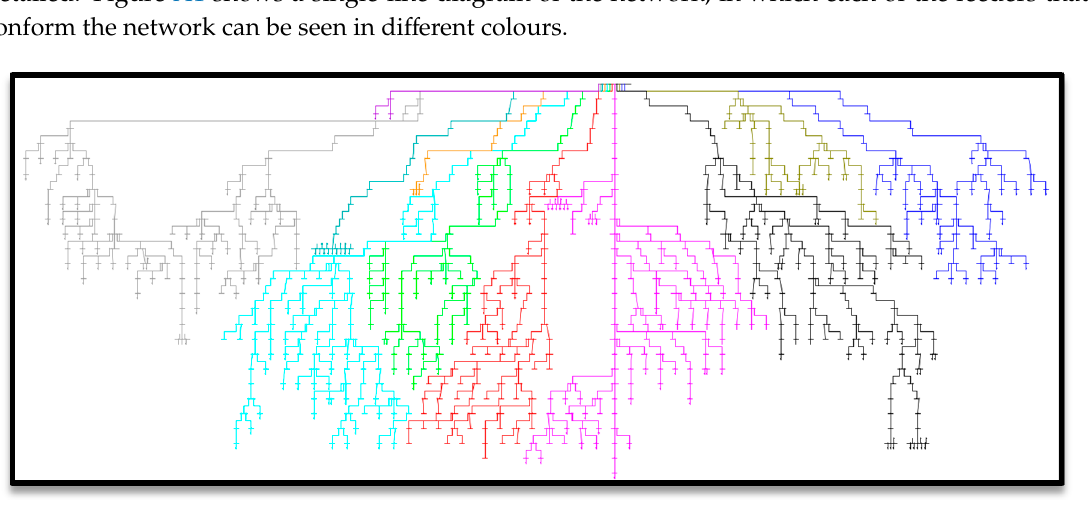
Table A1. Type of